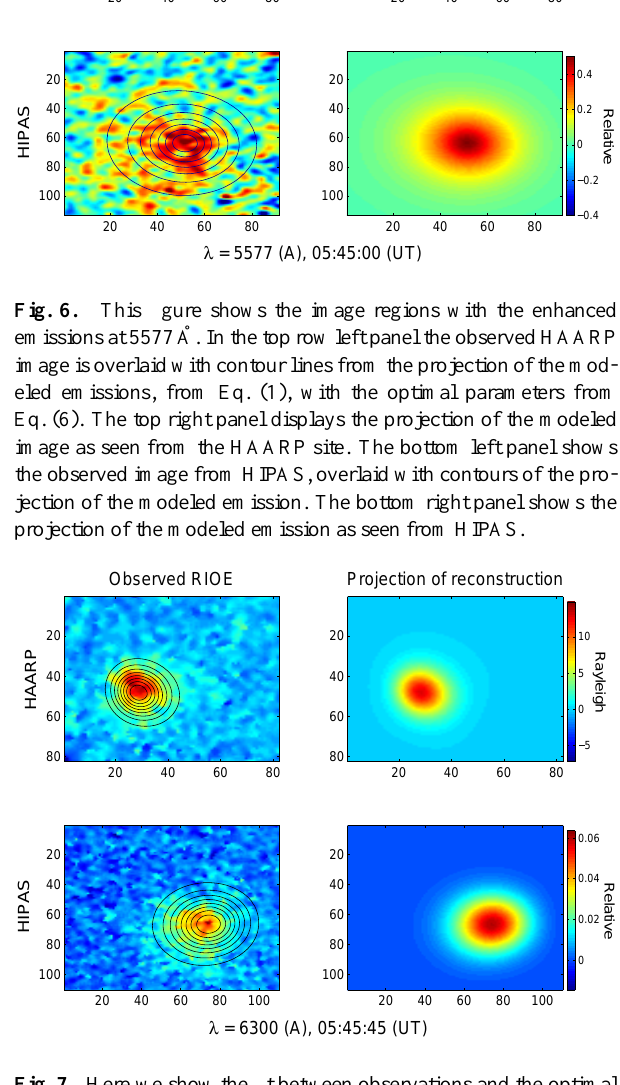
Fig. 7. Here we show the fit between observations and the optimal model for 6300 ˚A. The panels are organized identically with Fig.